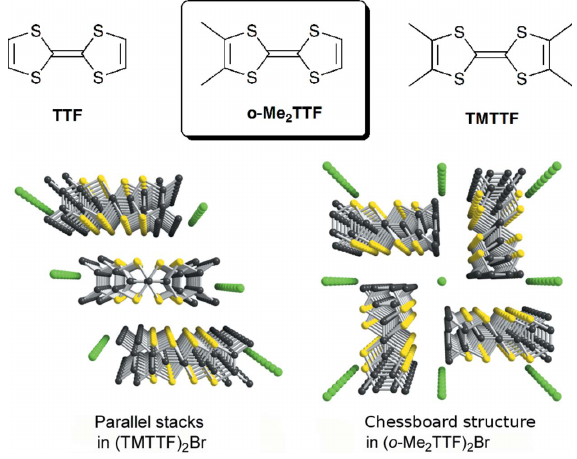
Figure 1 Perspective views along the stacking axis of two different salts, (TMTTF) 2 Br with parallel stacks, and ( o -Me 2 TTF) 2 Br with a chessboard